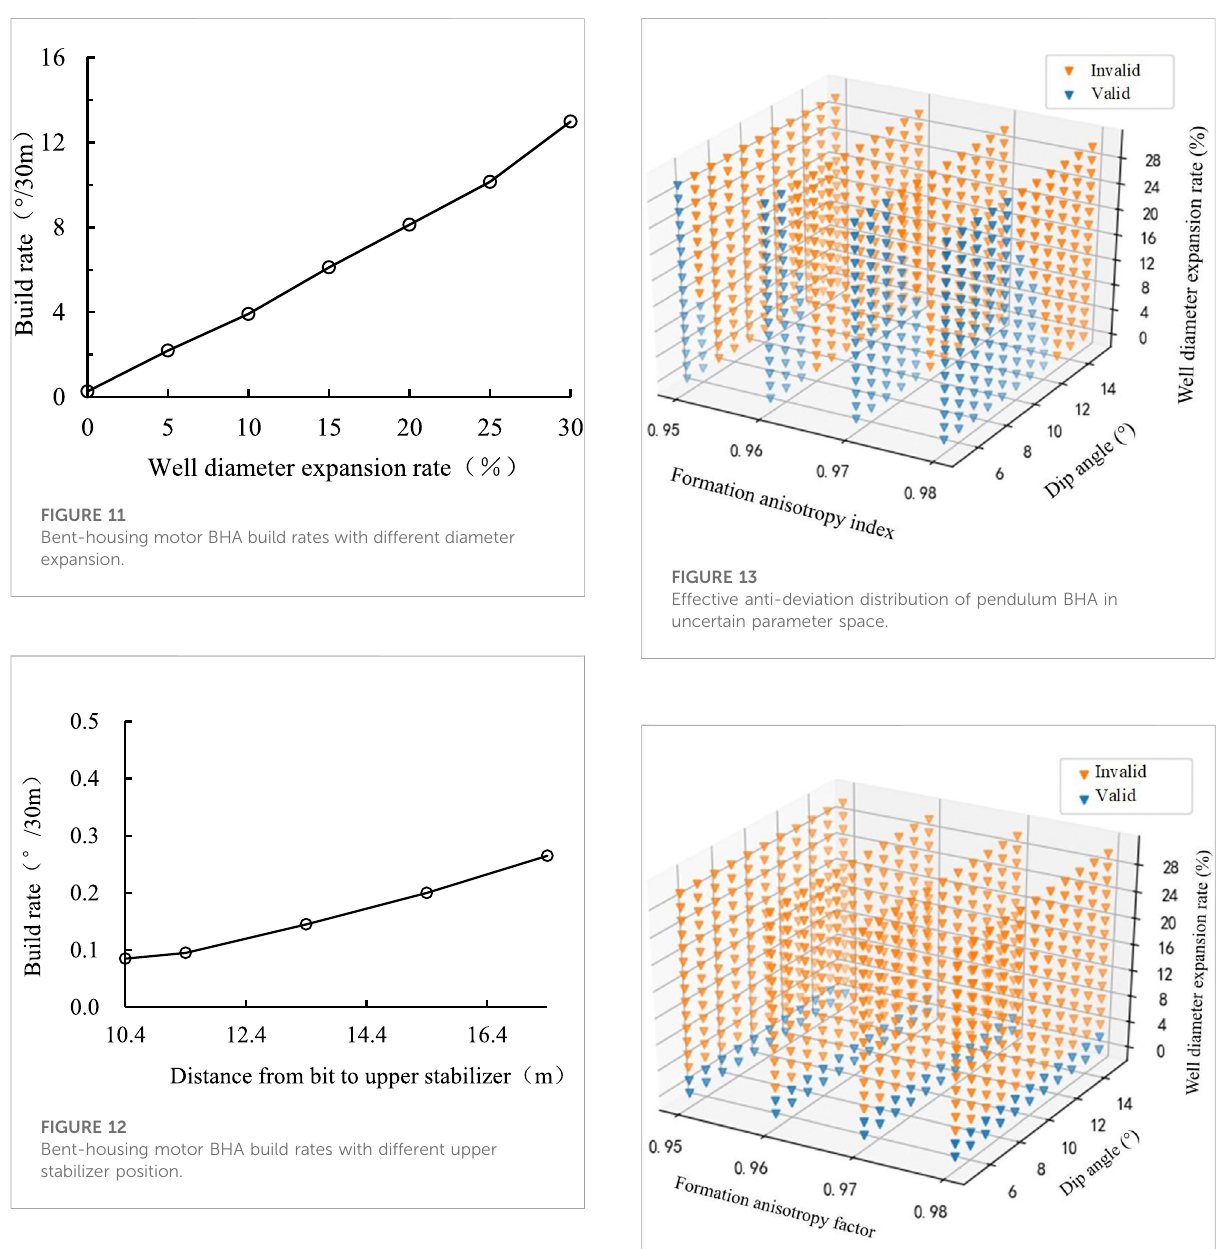
FIGURE 14 Effective anti-deviation distribution of bent-housing motor BHA in uncertain parameter